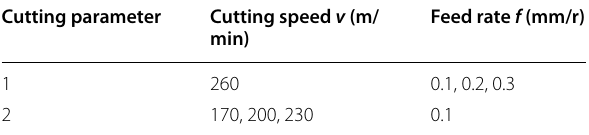
Table 3 Cutting parameters Cutting parameter